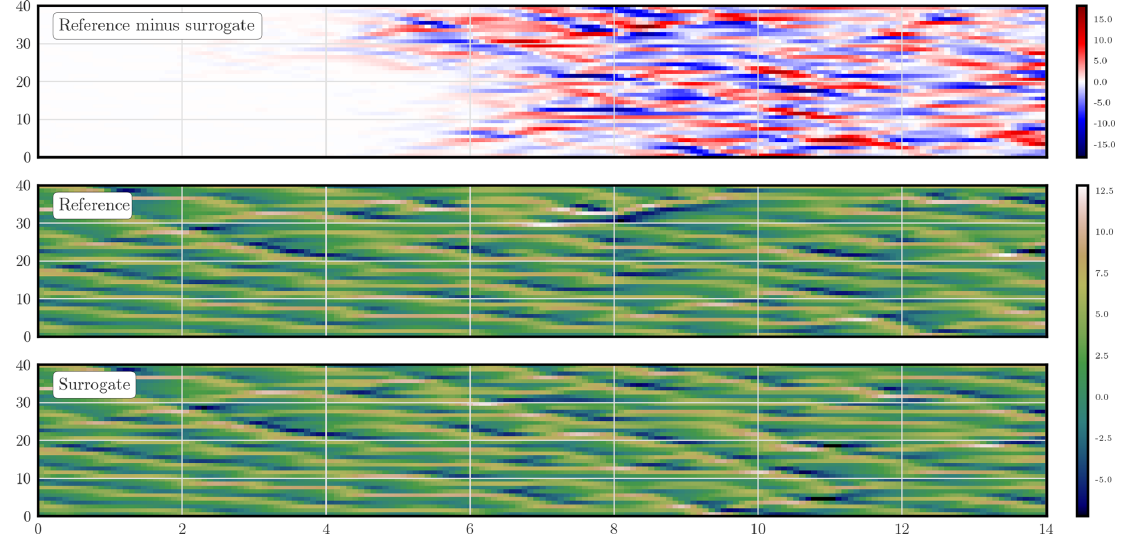
Figure 4. Density plot of the L96 reference and surrogate model trajectories, as well as their difference trajectory, as a function of the forecast lead time (in Lyapunov time unit). The observations are noiseless and dense; the model is not